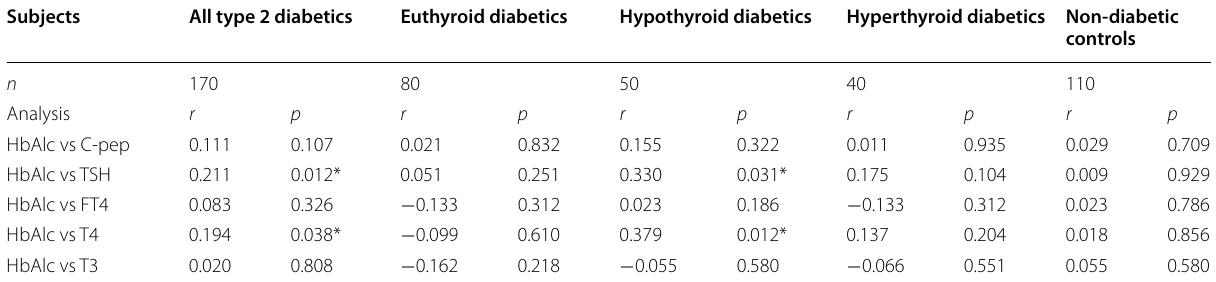
Table 2 Correlation analysis between HbA diabetics and non-diabetic